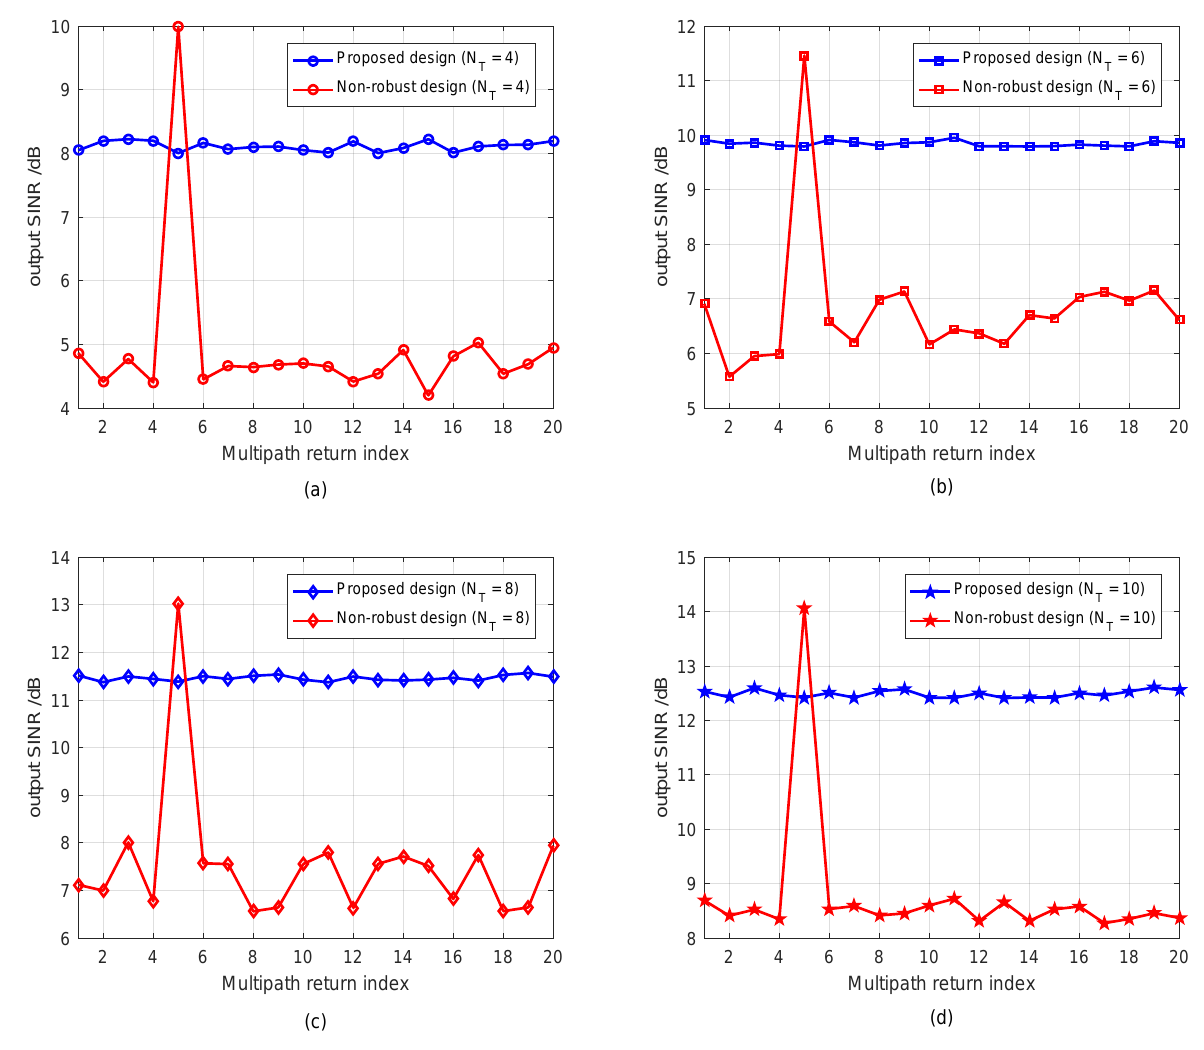
Figure 4. SINR values achieved with the proposed design and the non-robust design over different multipath propagation cases with various transmitting array sizes. ( a ) N T = 4, ( b ) N T = 6, ( c ) N T = 8, and ( d ) N T = 10.